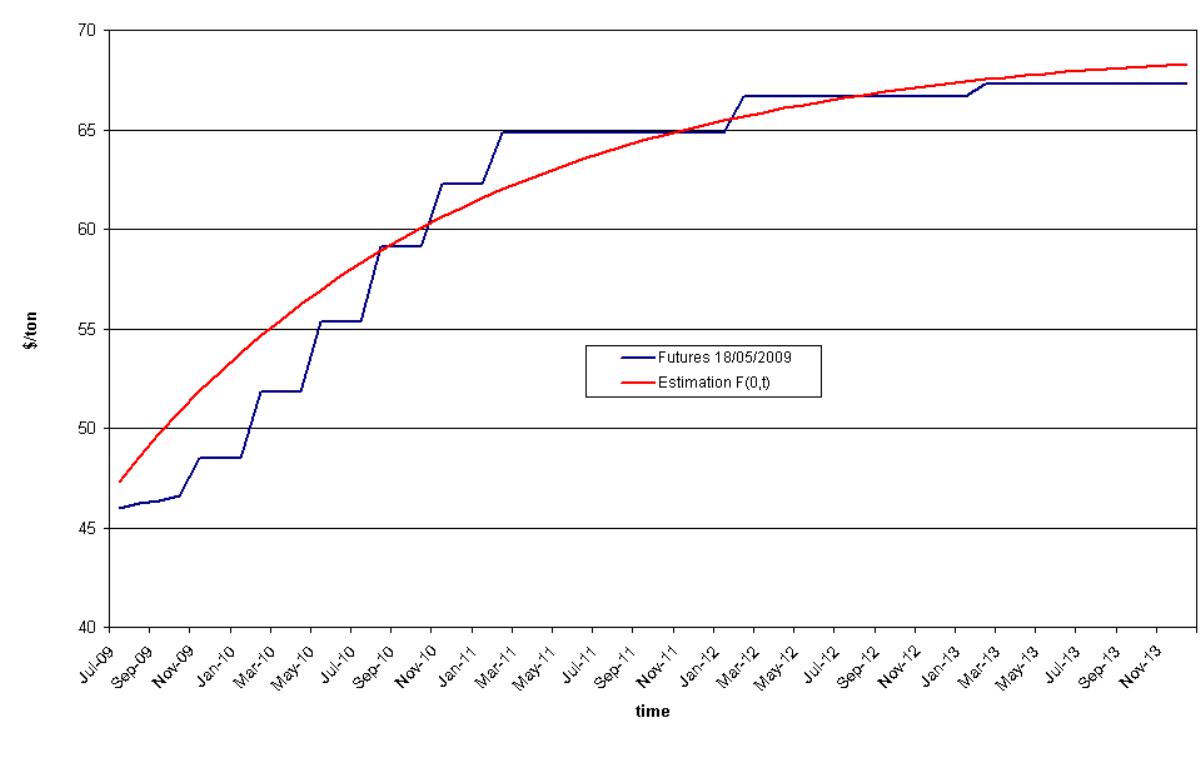
Figure 6. Futures prices of Appalachian coal on